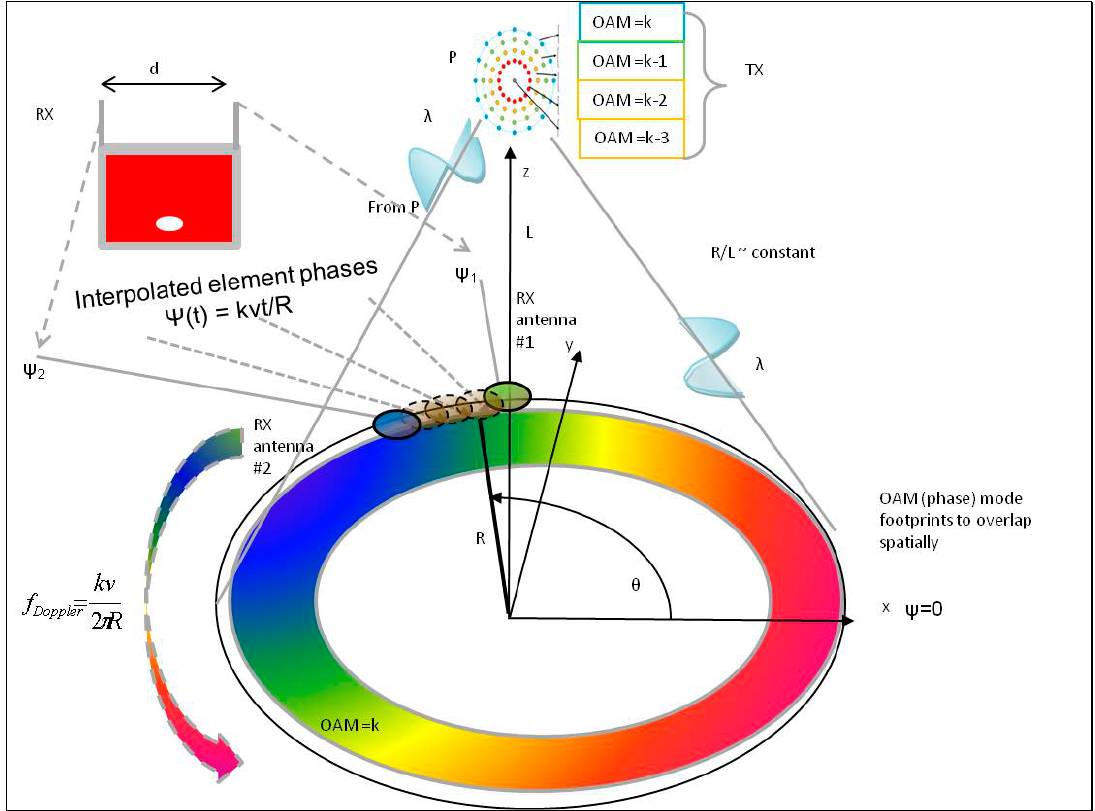
Figure 4. Applying pseudo-Doppler technique to OAM beams at a two-antenna receiver. Only the footprint of the OAM beam is shown; the color denotes the phase.